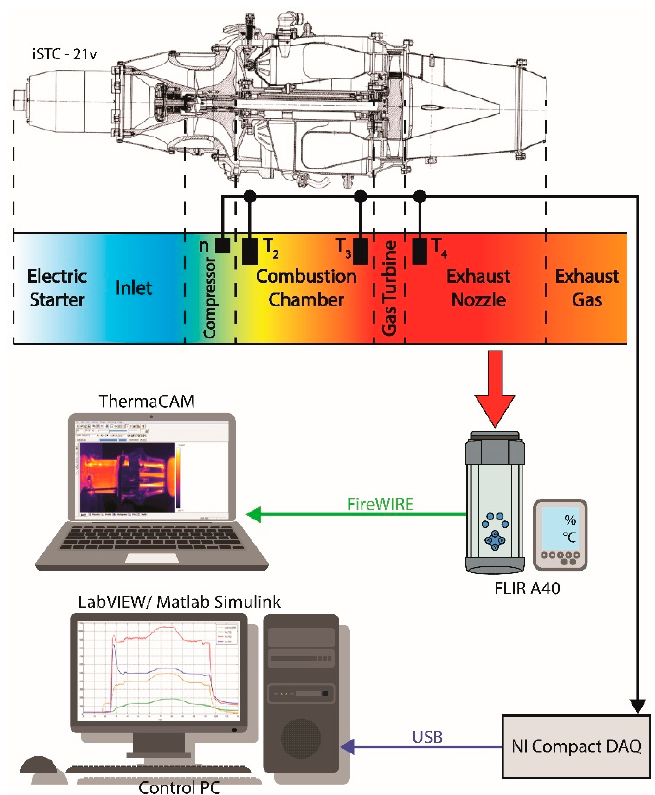
Figure 10. Schematic of the measurement and data acquisition system used in this study.